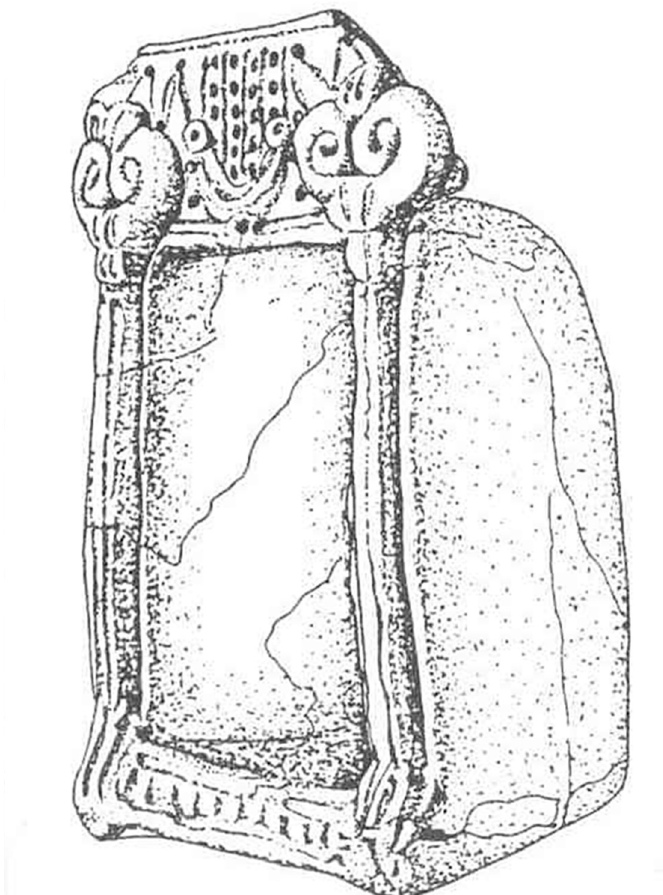
Figure 1. Tell el-Far ‛ ah shrine model (Keel and Uehlinger 1992: Figure